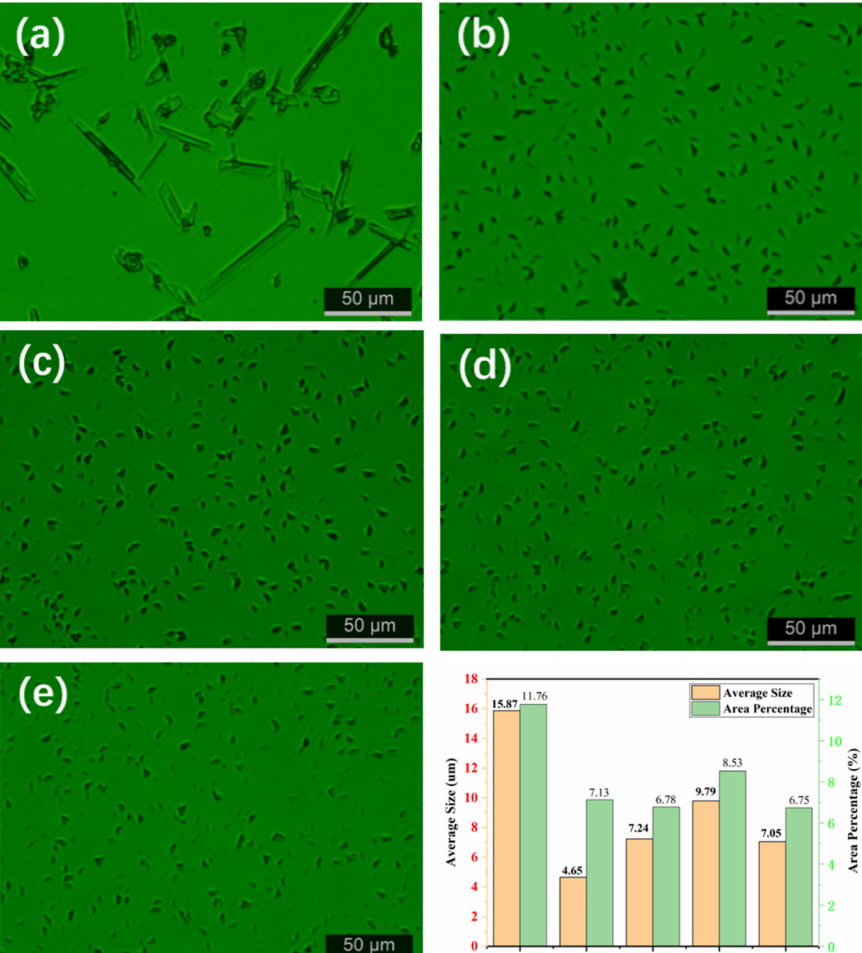
Figure 10. Polarized light microscopic images of wax in crude oil without and with the addition of bipolymers at 500 ppm, and the calculated average diameter and occupied area of wax (corresponding to precipitation amount) using ImageJ software. ( a ) No bipolymer, ( b ) TDA2024-18, ( c ) TDA2024-22, ( d ) TDA2024-28 and ( e )